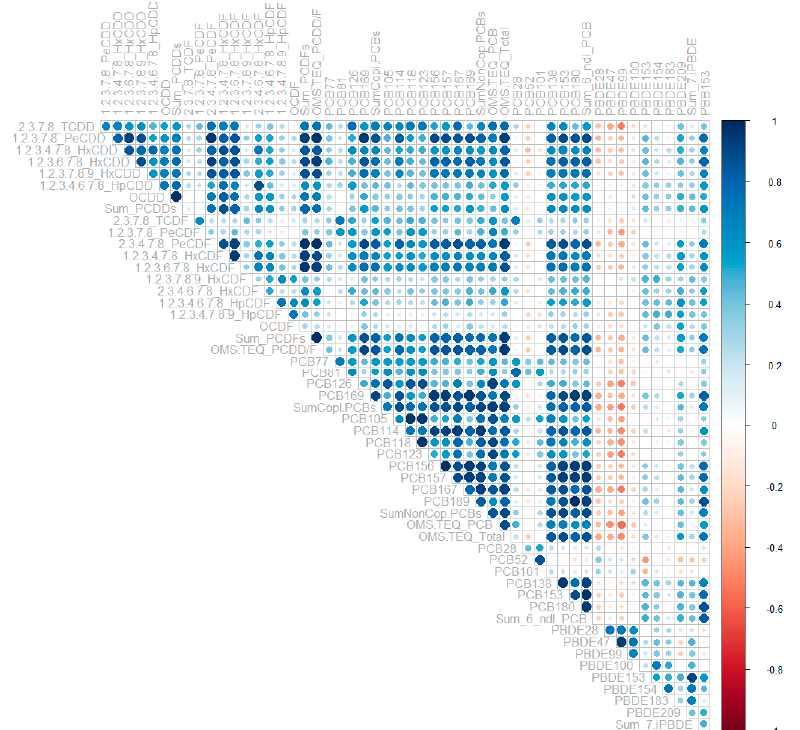
Figure 1. Heatmap displaying the Spearman’s rank correlation coefficients between main congeners of PCDD/Fs, PCBs, PBDEs, and PBB153. The color intensity relates to the correlation coefficient magnitude, and the color to the direction (blue, positive associations; red, negative associations). Of note, and unsurprisingly, PCDD correlates with each other, as does PCDF, in our study; certain ‘volatile’ POPs, such as PBDE28 (and PBDE47), PCB28, and PCB52, known to be metabolized, are negatively correlated to the lipophilic POPs.